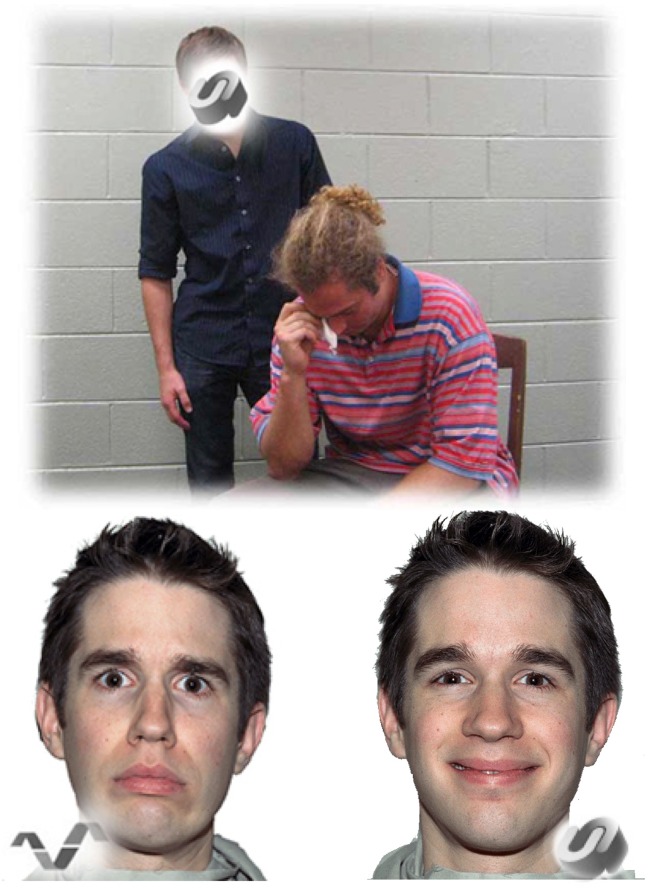
Examples of stimuli used for the emotional perspective taking task performed during functional neuroimaging.Participants were asked to make two types of decisions. During emotional perspective taking, participants were instructed to take into account the social interaction within a scene presented on the top of the screen, and to decide which of two emotional facial expressions best matches the face. During shape matching (control condition), participants were instructed to match the shape imbedded within the social scene with one of two shapes presented on the bottom of the screen. The individuals in this image have given written informed consent to publish this image.